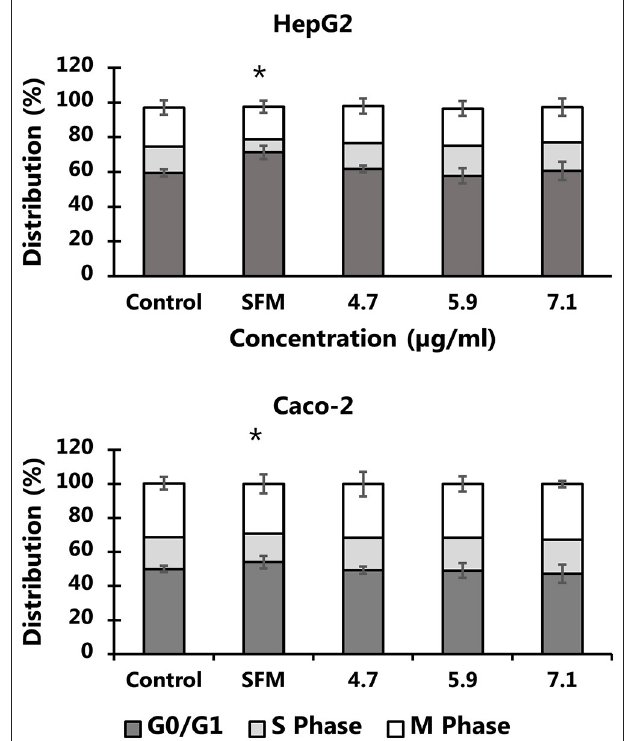
FIGURE 7 | Cell cycle distribution HepG2 and Caco-2 cells after 24h exposure to PET nanoplastics from black food containers. The results are means of 2-3 independent experiments (mean and standard deviation). The exposure to nanoplastics is not associated with changes in the cell cycle distribution ( P > 0.05), whereas culture of cells in serum free medium (SFM) shifted the cell cycle to G0/G1 phase from DNA synthesis phase (S). * P < 0.05, linear mixed effects model.